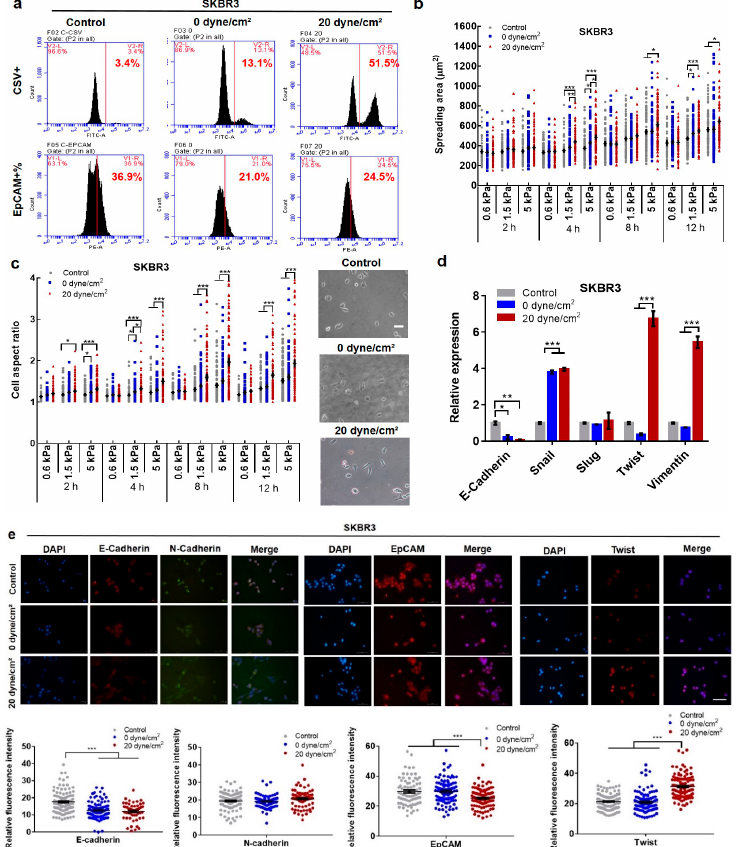
Figure 2. Fluid shear stress promotes the epithelial–mesenchymal transition (EMT) phenotype of suspended tumor cells. ( a ) Fluid shear stress enhances the cell-surface vimentin + (CSV + ) fraction while reduces the epithelial cell adhesion molecule + (EpCAM + ) fraction. Suspended tumor cells SKBR3 were treated under 0 and 20 dyne / cm 2 shear stress for 12 h. The percentages of CSV + and EpCAM + cells were analyzed by flow cytometry. n = 2 independent experiments; ( b , c ) Fluid shear stress induces cell spreading and elongated morphology. The treated SKBR3 cells were cultured on 0.6, 1.5, and 5 kPa polyacrylamide gels. Cell images were taken at 2, 4, 8, and 12 h, respectively. The spreading area and cell aspect ratio were calculated; ( d ) Fluid shear flow upregulated / downregulated the expressions of mesenchymal / epithelial genes. n = 3; ( e ) Fluid shear stress enhanced / decreased the expressions of mesenchymal / epithelial genes at the protein level. Breast cancer cells were treated similarly as in ( a , d ). The expressions of E-cadherin, EpCAM, N-cadherin, and Twist were examined through immunofluorescence. The nucleus was counterstained with 4 (cid:48) 6-diamidino-2-phenylindole (DAPI). Scale bar in ( c , e ): 50 µ m. At least 100 cells were measured for each condition. The statistics were conducted using Analysis of variance (ANOVA) with the post hoc Bonferroni test in ( b – e ). * p < 0.05; ** p < 0.01; *** p <